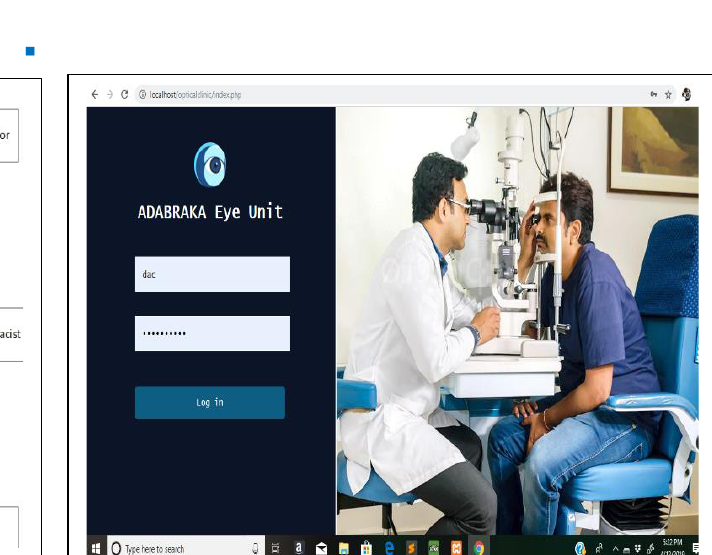
Figure 15. Context Diagram